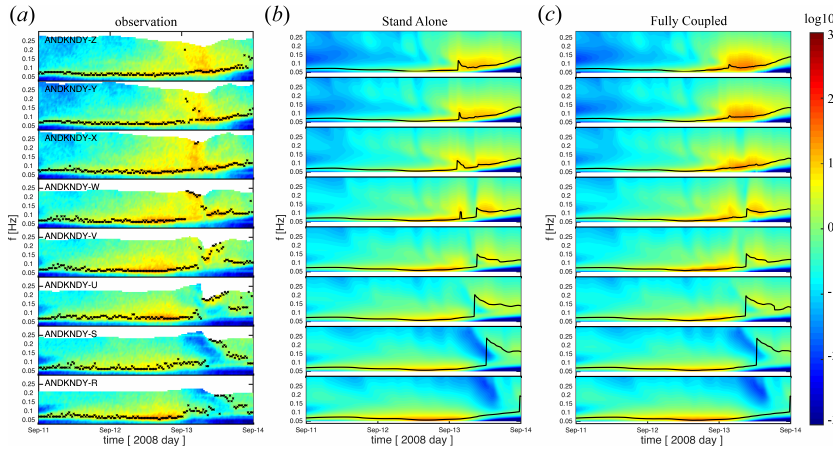
Figure 19. Frequency spectrum at nearshore quick deployed gauges comparing observation ( a ) versus Stand alone WW3 simulations ( b ) and Fully coupled wave-surge simulation ( c ). The time series of peak frequency is shown in each subplot. All model configurations and results are pre-decisional and for official use